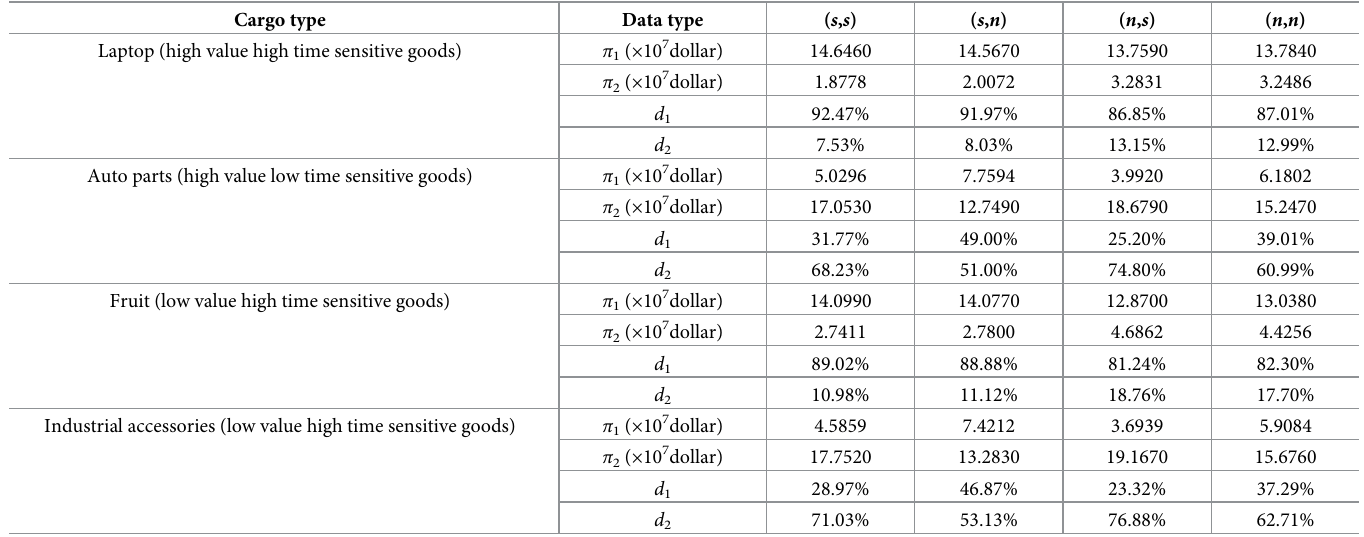
Table 6. Market share and profit (with subsidies) of CR Express and shipping for different service